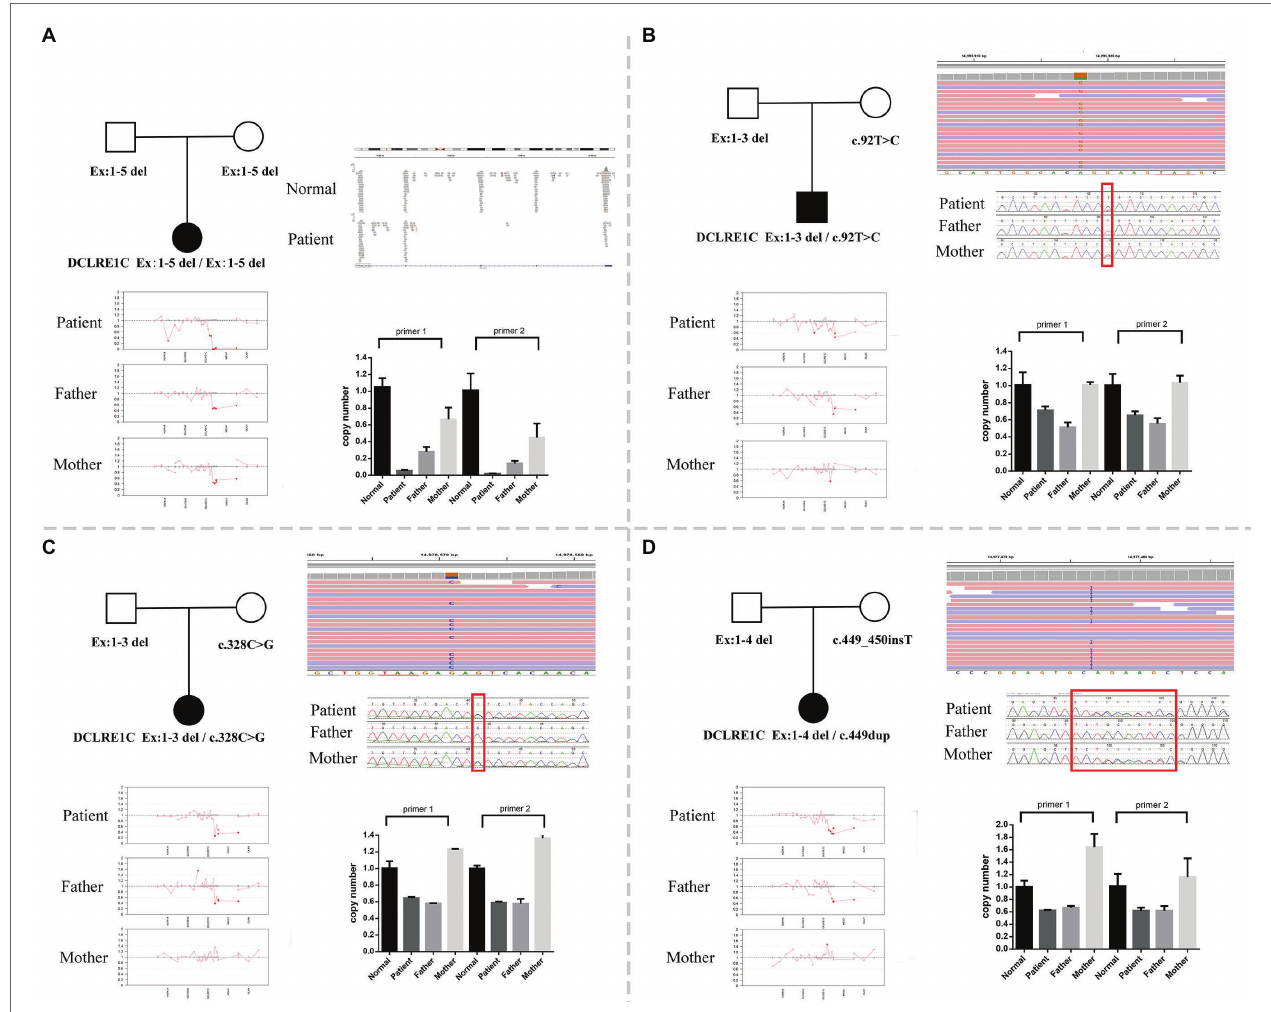
FIGURE 1 | (A) A family pedigree of patient 1. Whole-exome sequencing (WES) revealed a homozygous deletion of DNA cross-link repair 1C ( DCLRE1C ) gene from exons 1–5 in this patient, and quantitative PCR (qPCR) verified it. (B) A family pedigree of patient 2. WES revealed exons 1–3 deletion and a novel rare variant (c.92T>C, p.L31P). The qPCR verified exons 1–3 deletion, and Sanger sequencing confirmed the variant (c.92T>C, p.L31P). (C) A family pedigree of patient 3. WES revealed heterozygous exons 1–3 deletion and a novel rare variant (c.328C>G, p.L110V). The qPCR verified exons 1–3 deletion, and Sanger sequencing confirmed the variant (c.328C>G, p.L110V). (D) A family pedigree of patient 4. WES revealed heterozygous exons 1–4 deletion and a novel frameshift variant (c.449_450insT). The qPCR verified exons 1–4 deletion, and Sanger sequencing confirmed the variant (c.449dup, p.His151Alafs *